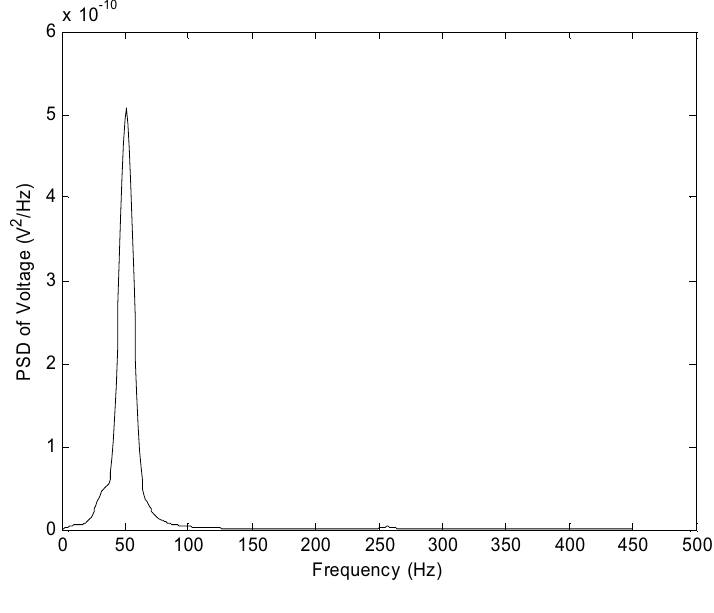
Fig. 6. Frequency spectrum of the PZT sensor voltage of Fig. 5.